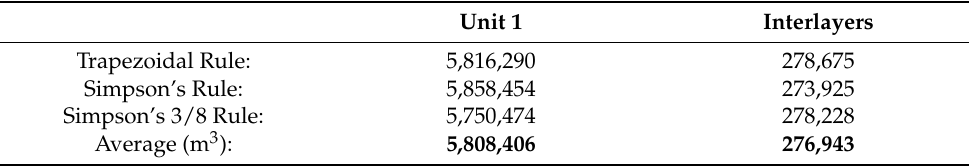
Table 2. Reserve of the unit 1 and interlayers calculated using structural maps.